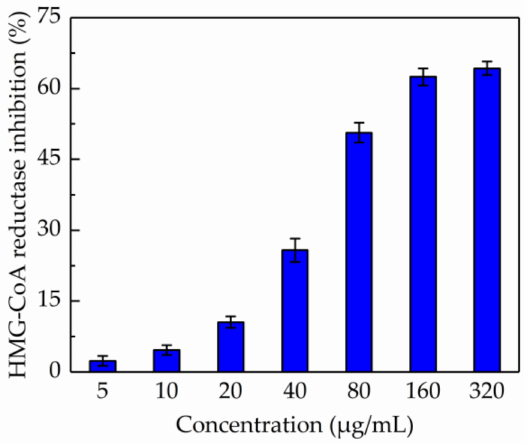
Figure 5. Inhibition of β -hydroxy- β -methylglutaryl-CoA reductase activity by total phenolic